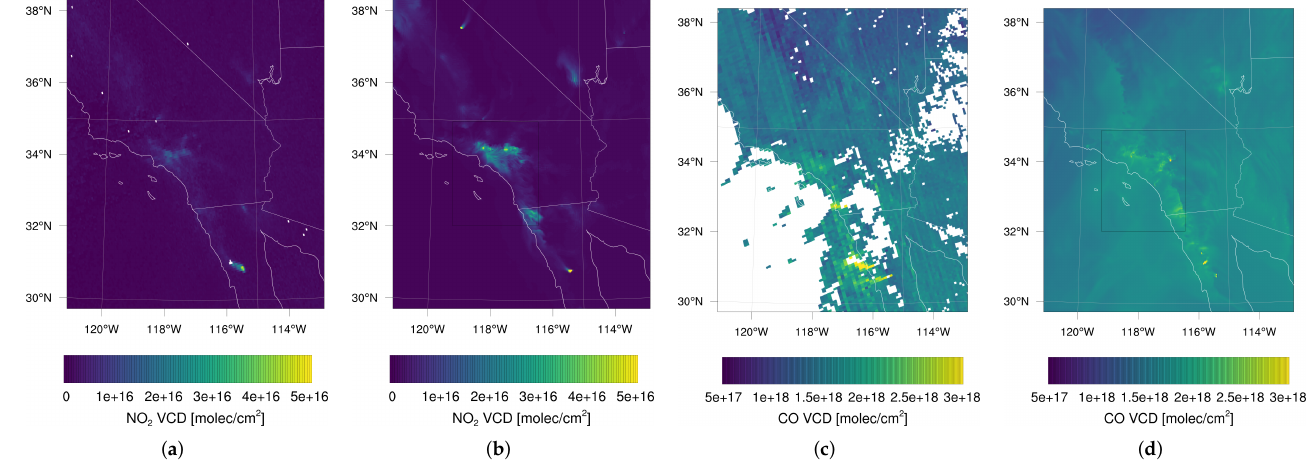
Figure 13. Observed ( a ) and modeled ( b ) NO 2 VCD on 5 July 2018 (8 p.m.). Observed ( c ) and modeled ( d ) CO VCD on 6 July 2018 (9